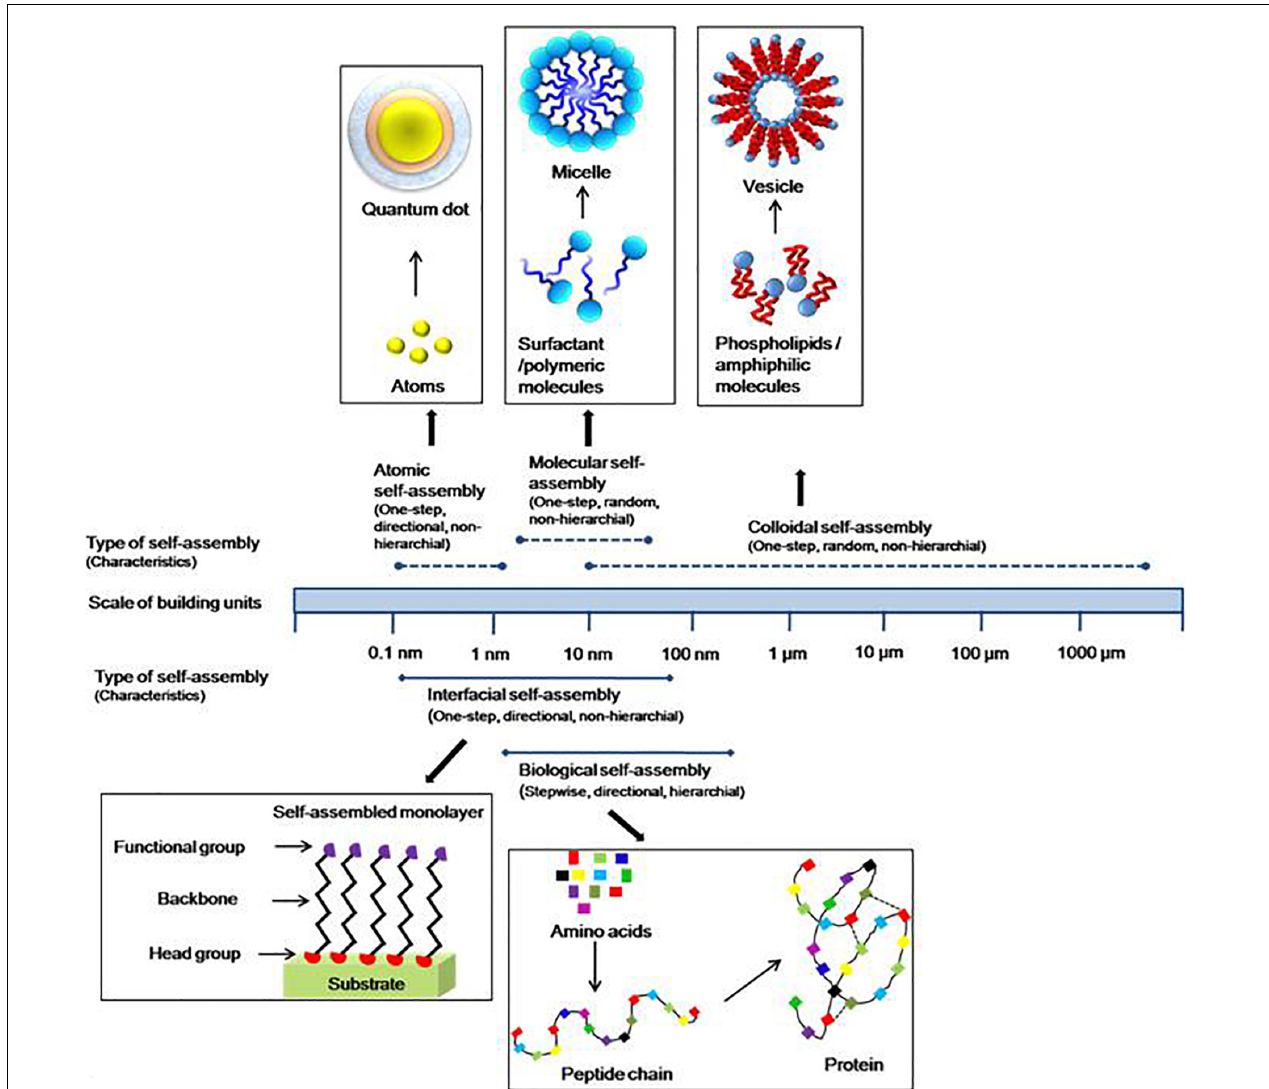
FIGURE 2 | Atomic, molecular, colloidal self-assemblies based on size or nature of building units, and biological, interfacial on the basis of system where the self-assembly occurs. The length range is of structural units.